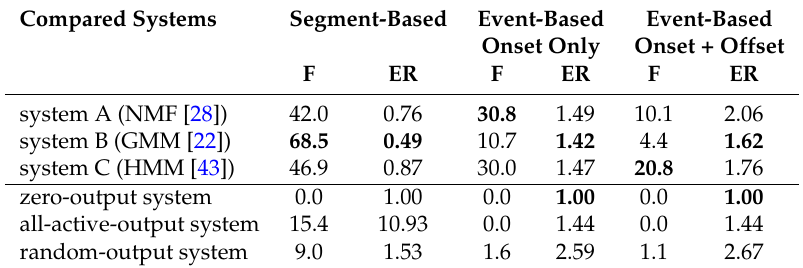
Table 3. Comparing systems using different metrics calculated using instance-based averaging, 1 s segment, 250 ms